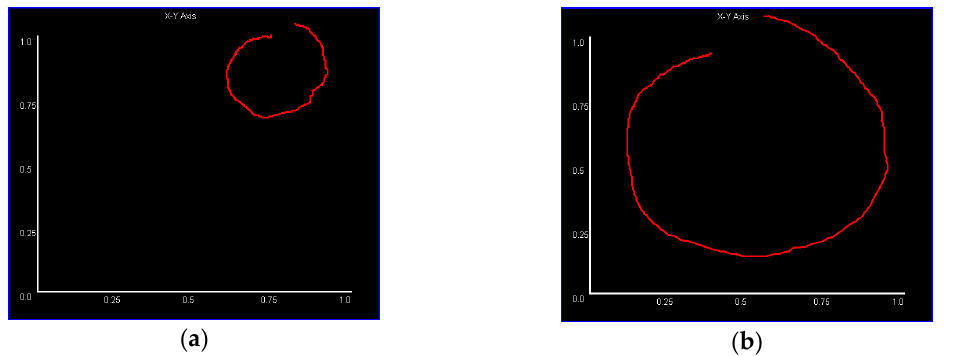
Figure 6. This figure shows similar gesture (“circle” gesture mapped in X-Y plane) but in a different position relative to device, where the red line is the mapping of a 3D gesture. ( a ) This gesture is farther and more biased from device. ( b ) This gesture is appropriately behaved on the center and top of the device.